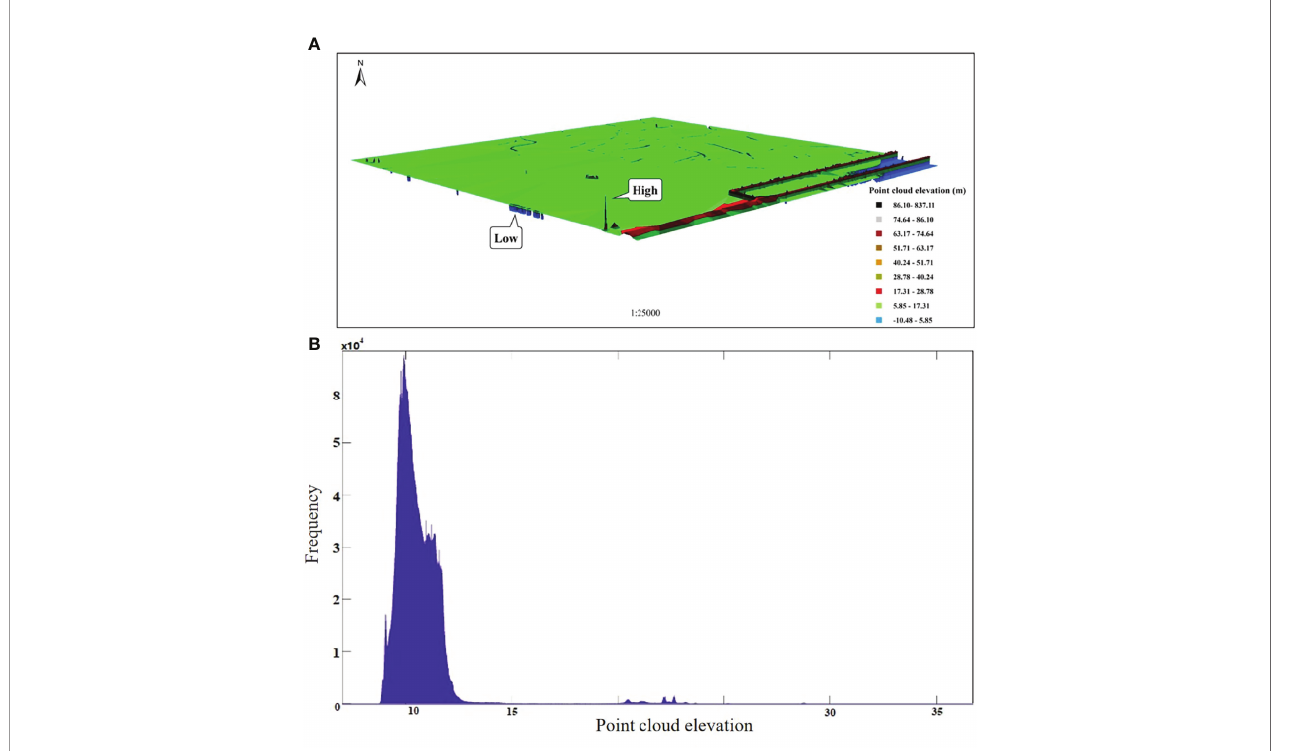
FIGURE 7 | (A) the original point cloud data pro fi le; (B) the original point cloud data elevation statistical histogram.